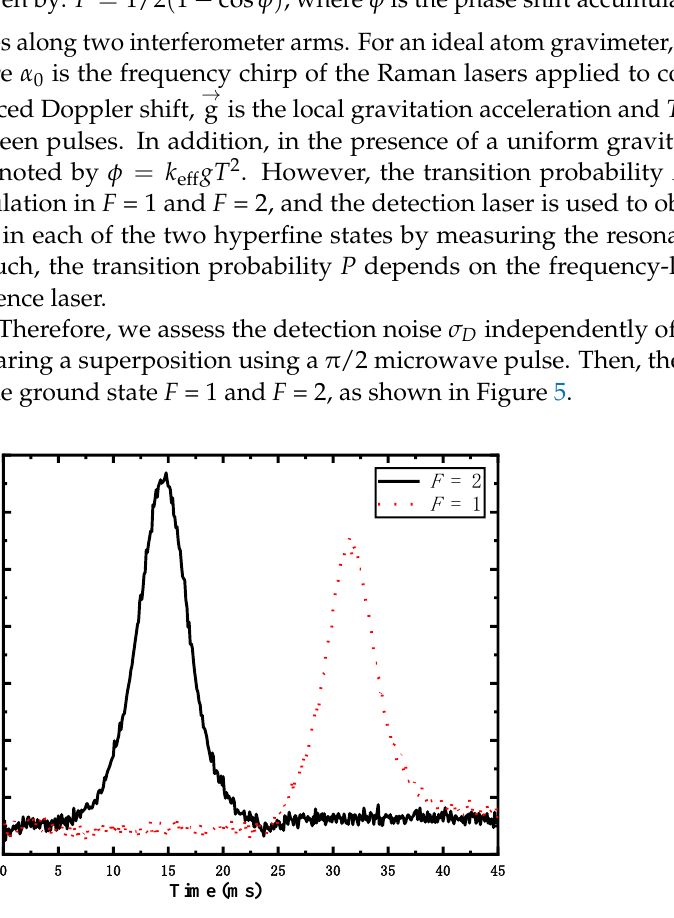
Figure 5. Typical plot of detection signals after π /2 microwave pulse; the two curves are for the F = 1 and F = 2 channels, respectively.